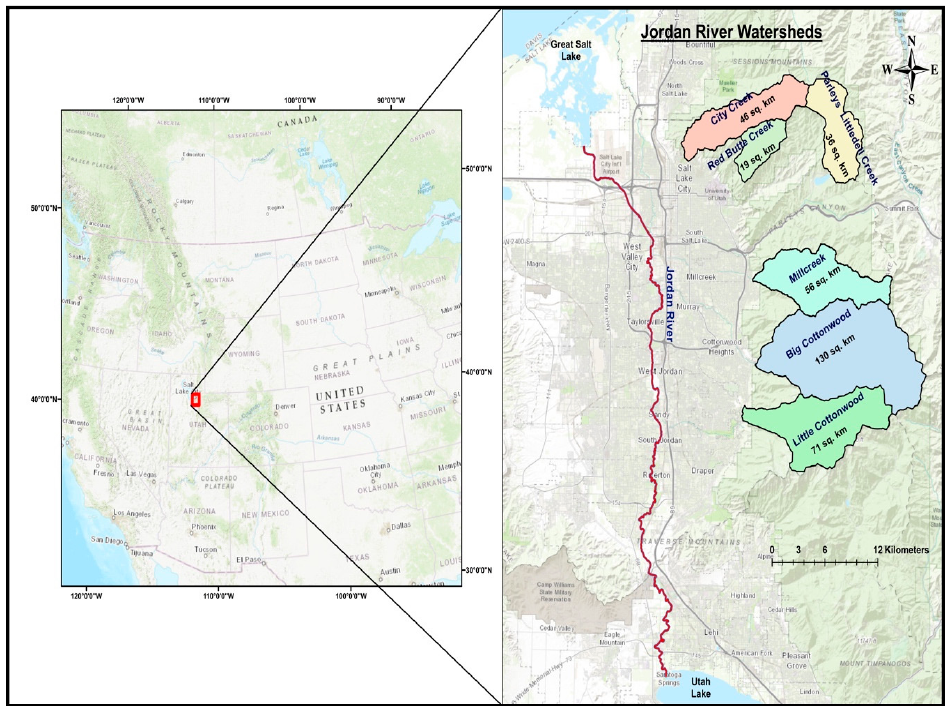
Figure 1. Map of Jordan River Basin and locations of the six studied watersheds.